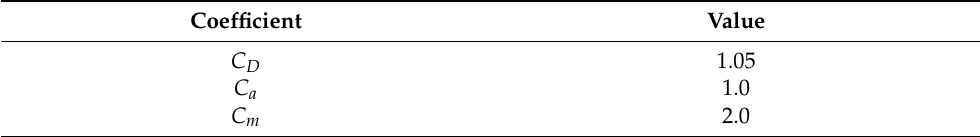
Table 3. Coefficients used in the Morison